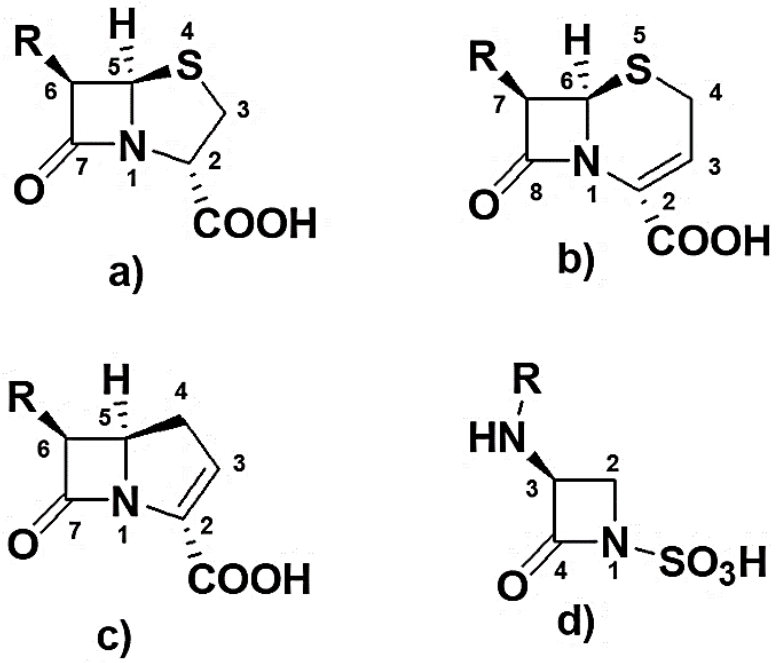
Figure 1. Structures drawn using the ChemDraw Ultra 7.0 software (Chem Office 2002), of represen- tative β -lactams with the correct numbering indicated on the basic ring systems. Penicillin scaffold ( a ); cephalosporin scaffold ( b ); carbapenem scaffold ( c ); monobactam scaffold ( d ).